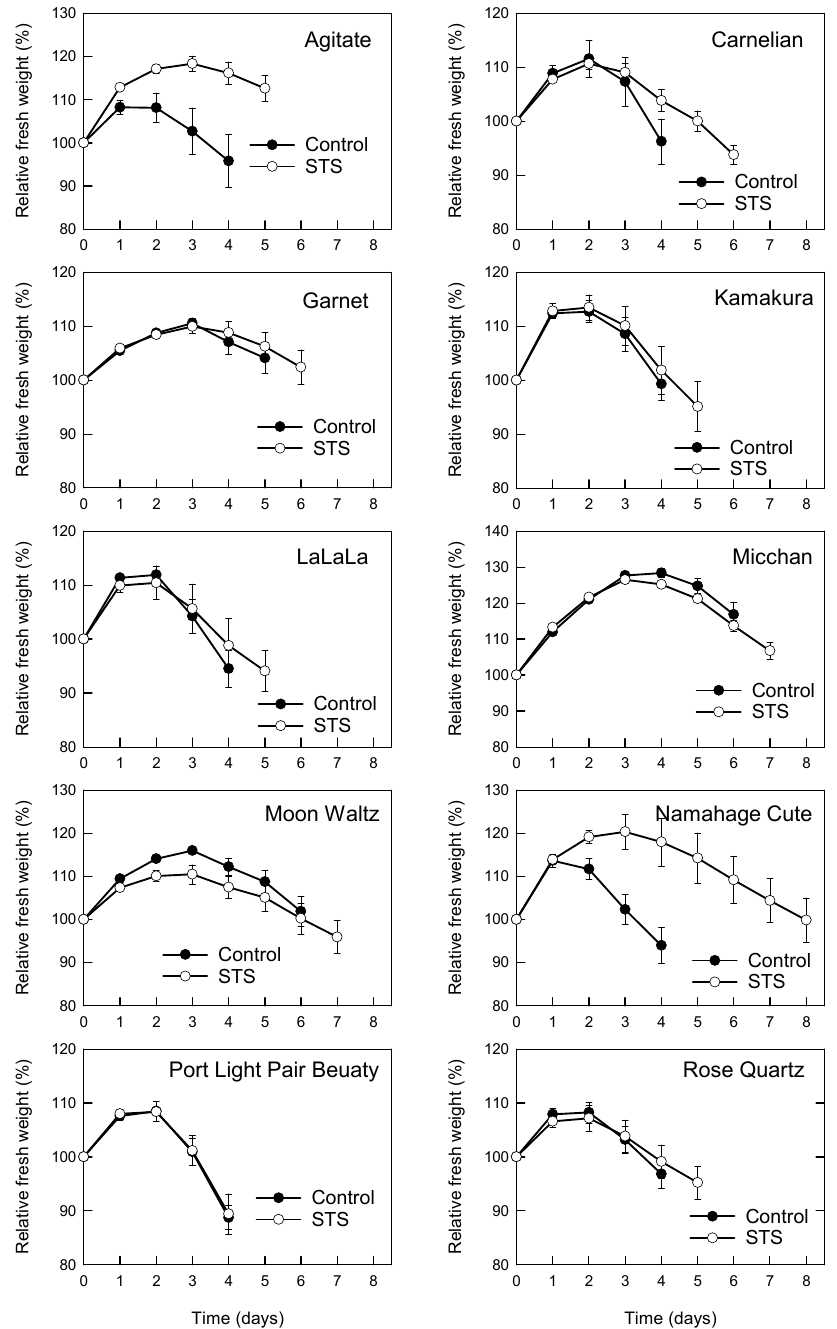
Figure 5. The relative fresh weight of cut dahlia flowers after treatment with STS of 10 dahlia cultivars. Values are the means of six replicates ± SE.